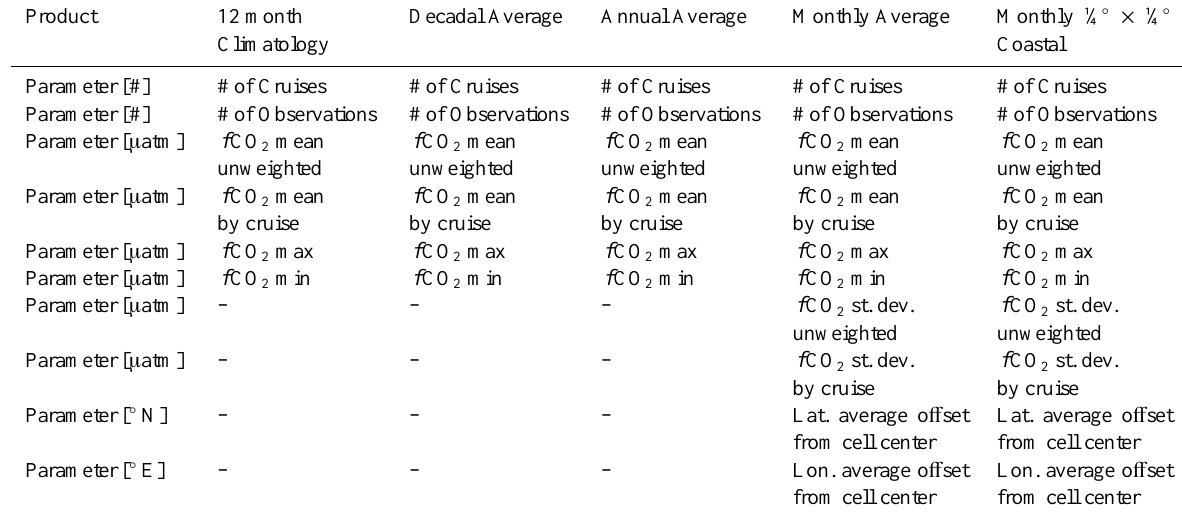
Table 1. Gridded products and available parameters for SOCAT